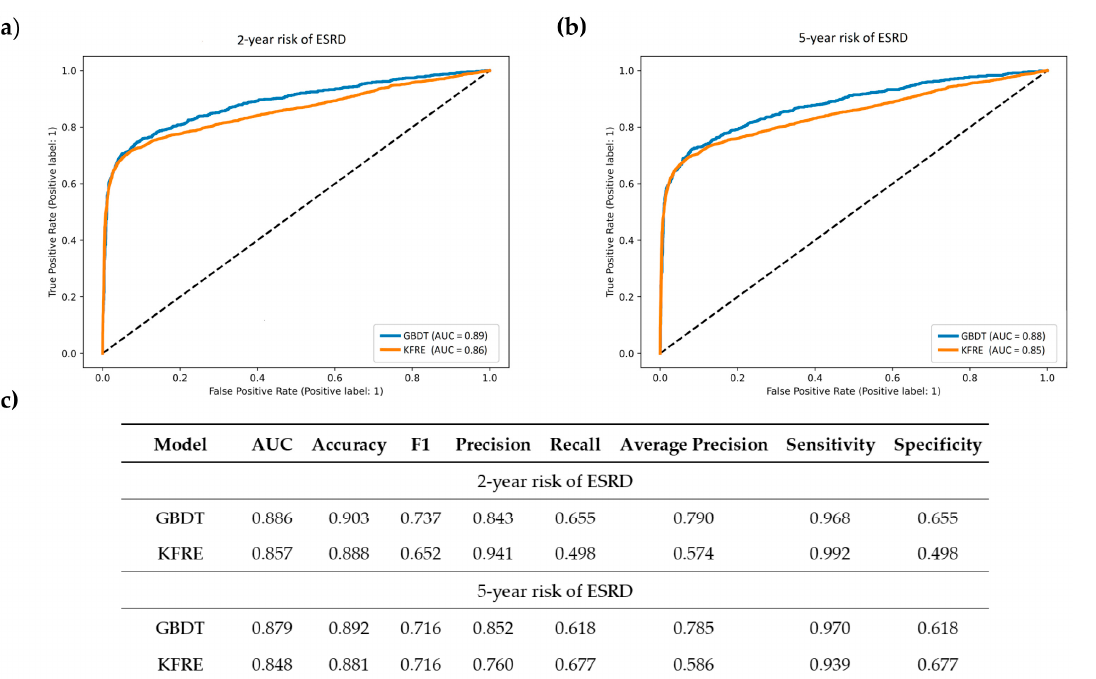
by the red lines. Figure 4d–f showed the interaction effects between eGFR and the use of insulin ( d ), eGFR and the use of RAS inhibitor ( e ), eGFR and HTN ( f ) in the prediction model. The dotted lines represent while the SHAP value is zero. Abbreviations: SHAP—Shapley additive explanation; eGFR—estimated glomerular filtration rates; HGB—hemoglobin; UPCR—urine protein/creatinine ratio; RAS—renin–angiotensin system; HTN—hypertension; GBDT—gradient boosting decision tree. Red/blue—Features that push the prediction higher are shown in red, and those pushing the prediction lower are blue. A gray area refers to the patient distribution by eGFR levels.